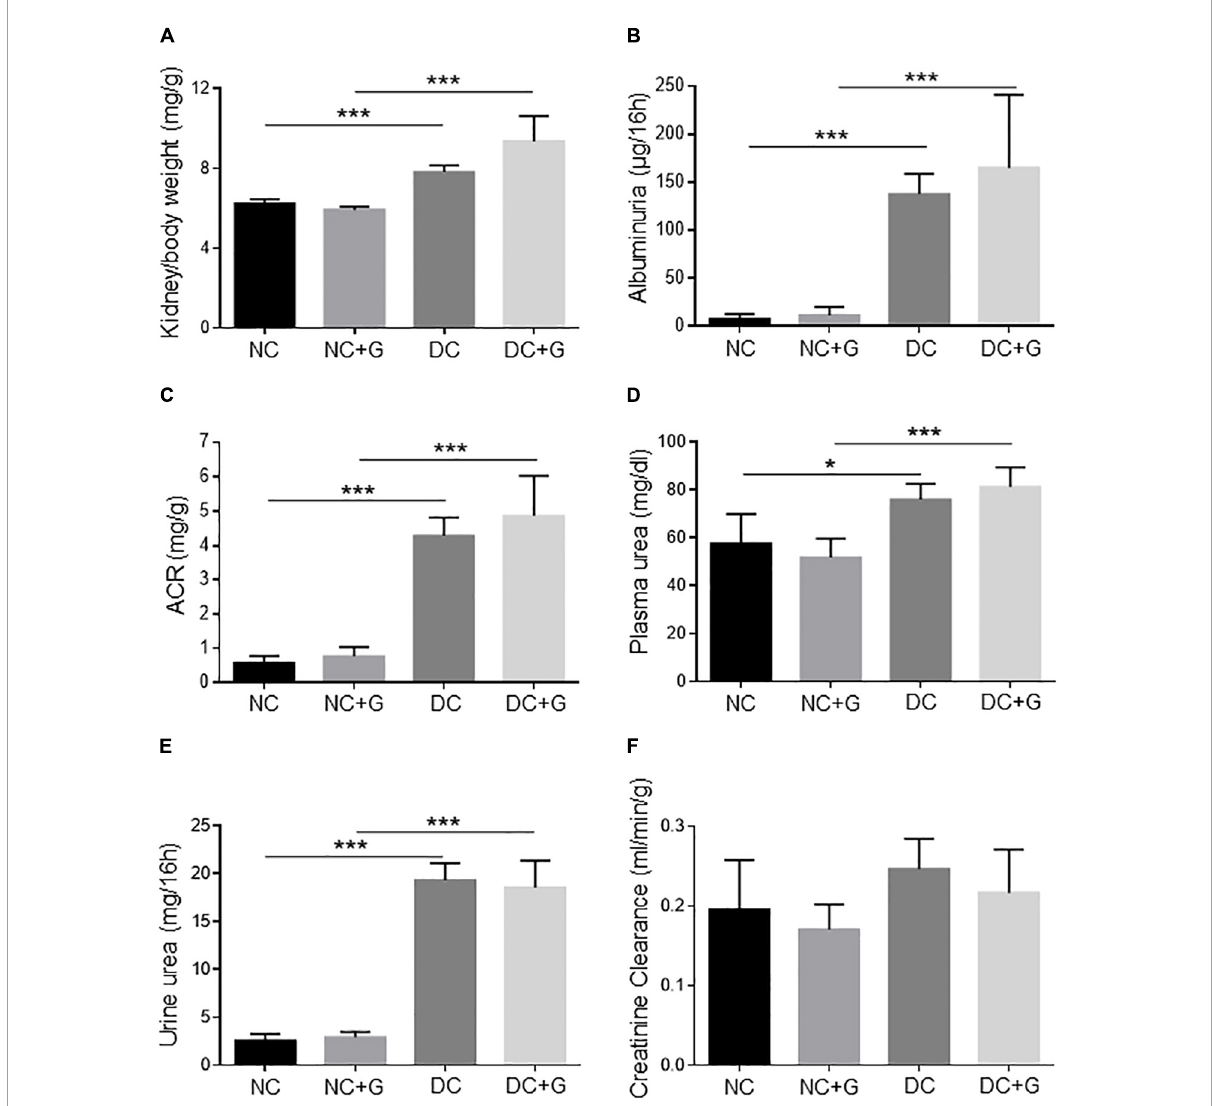
FIGURE2 Glucosamine does not alter renal function in diabetic mice. (A) Kidney/body weight, (B) albuminuria, (C) albumin creatinine ratio, (D) plasma urea, (E) urine urea, and (F) creatinine clearance are determined. Mean ± SEM, n = 6–10, * p < 0.05, *** p <